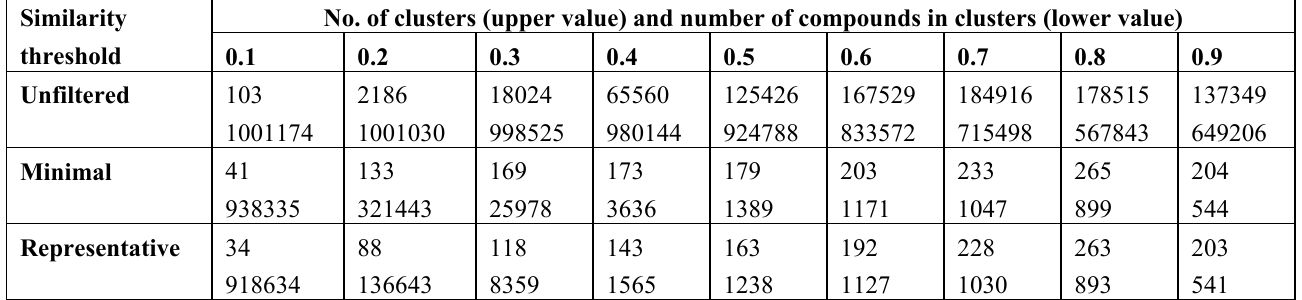
Table 2. Results of clustering TESTDB with Nst =10 and minimal cluster size=2.